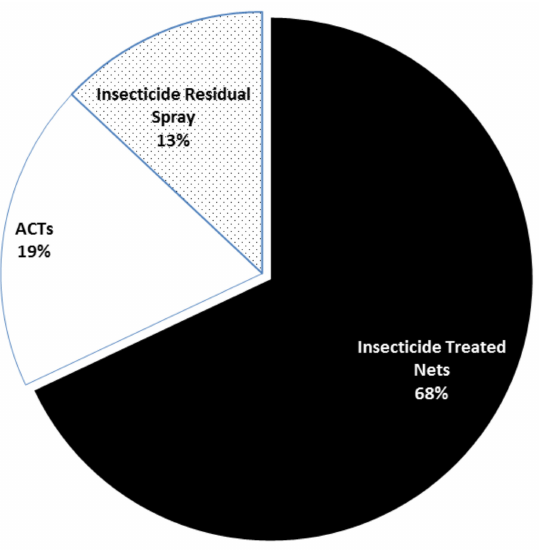
Figure 3. Contribution of different tools to malaria control [69]. As a result of the huge contribution of insecticide treated bed nets, their consistent use is highly advocated in order to reduce or restrict the use of antimalarials in malaria control. This will reduce drug resistance due to drug